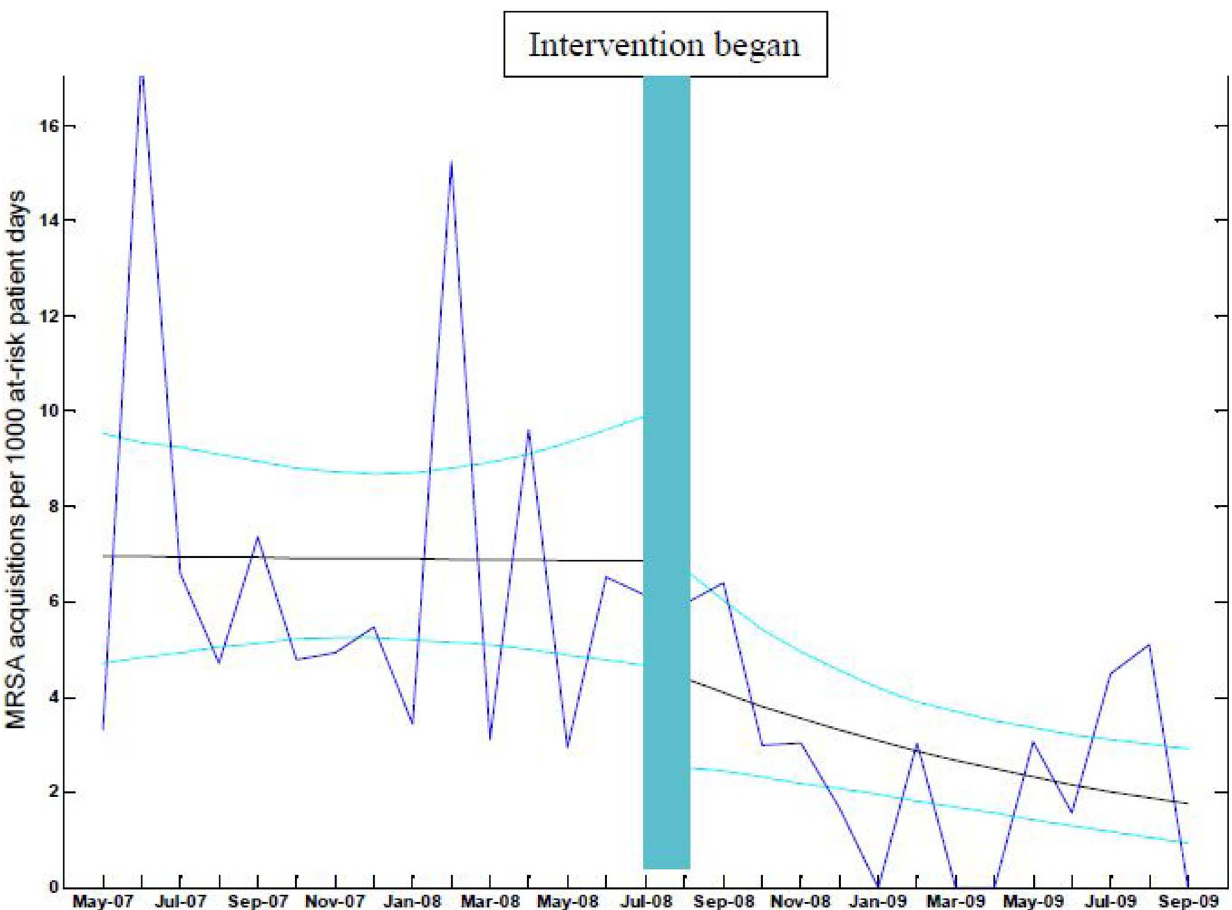
Figure 2. Segmented regression model. Incidence of MRSA per 1000 at risk patient days in ICU over the study period. There was a decline in MRSA acquisition of 7% per month in the intervention phase, which was a significant change in slope compared with the control phase (95% CI for change in slope 1.9 to 12.8% reduction). The dark blue lines are the data, the black lines are the model best fit results and the light blue lines are the upper and lower values of the 95% credible intervals for the model estimates.